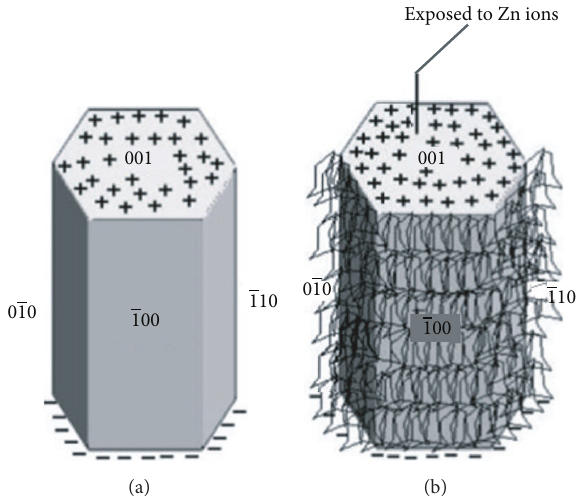
Figure 2: Attachment of hexamine to the nonpolar facets of the zincite crystal allows the growth of the crystal in the (0001) direction. (a) Hexagonal ZnO crystal and (b) possible attachment of hexamine on to the nonpolar facets leaving the polar face exposed allowing further crystal growth along the 𝑐 -direction (reproduced with the permission from [56]).